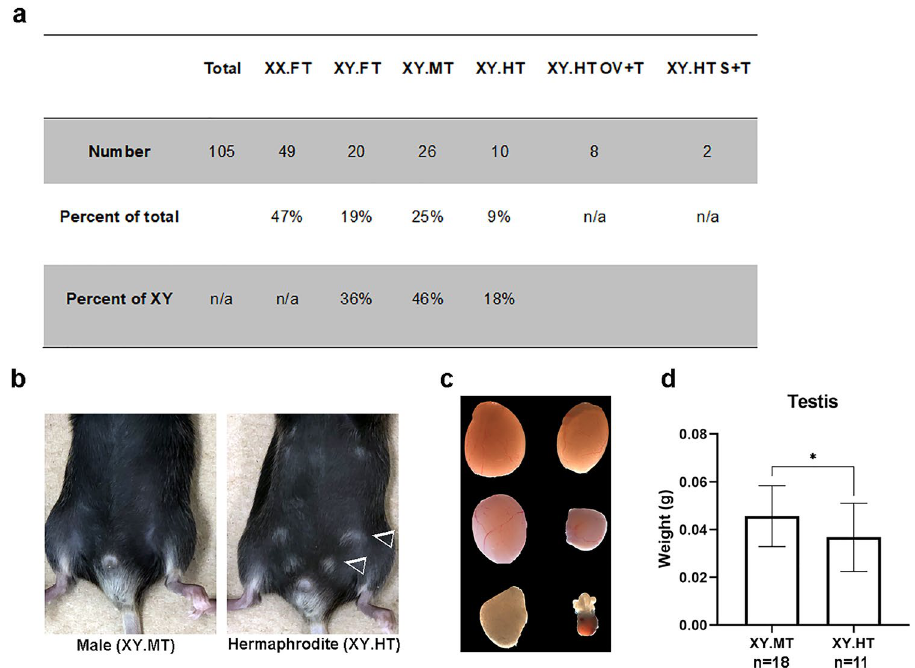
Figure 2. Characteristics of true hermaphrodites from the B6.Y TIR cross. ( a ) Distribution of genotypes and sex phenotypes among the offspring of XY TIR males. ( b – d ) Male (XY.MT) and hermaphrodite (XY.HT) phenotypes. ( b ) Different anogenital distance and mammary gland development in males and hermaphrodites (arrowheads point to mammary glands); ( c ) Males show variable testes weight with either two testes of similar weight (top row) or one testis larger than the other (middle row). Hermaphrodites have unilateral small testis and contralateral ovary (XY.HT OV + T) (bottom row) or a streak gonad (XY.HT S + T) (not shown); ( d ) Testis weight in males and hermaphrodites. Error bars show standard deviation. Asterisk indicates significant difference * P < 0.05 (one-tailed